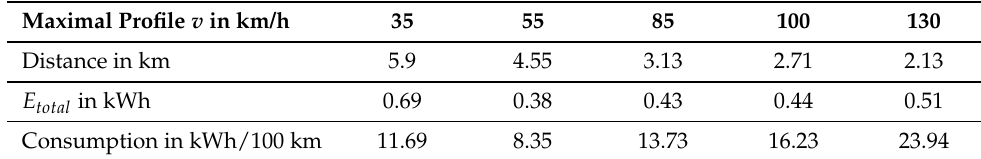
Table 7. Distance traveled and energy consumption per 100